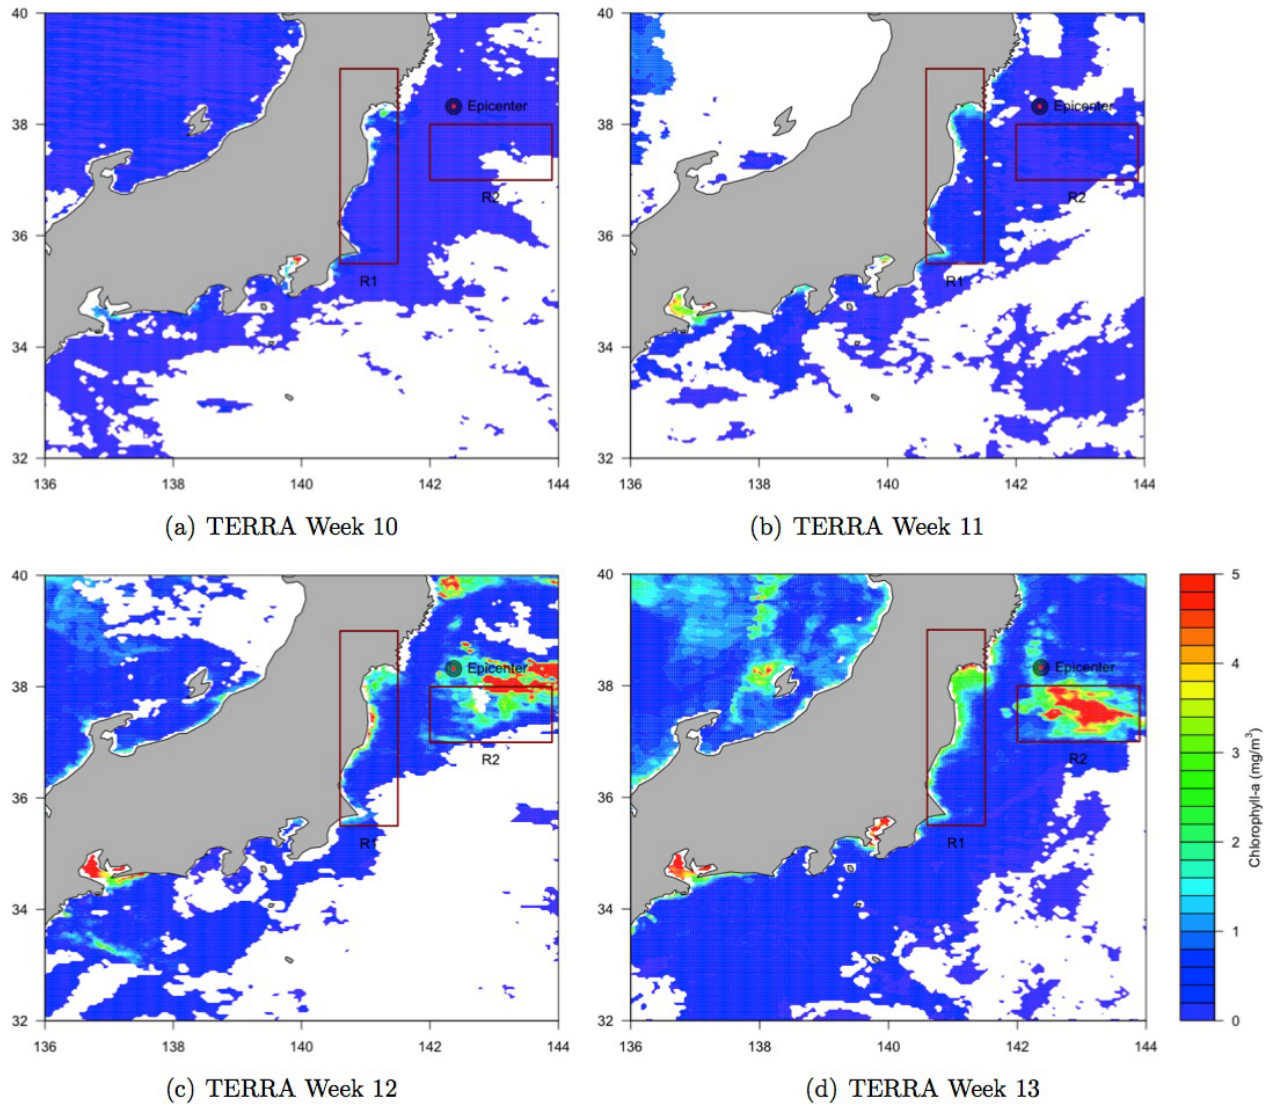
Figure 5. Chlorophyll concentrations for the 4 weeks after the tsunami using TERRA. The vertical axis indicates latitude degrees north, and the horizontal axis indicates longitude degrees